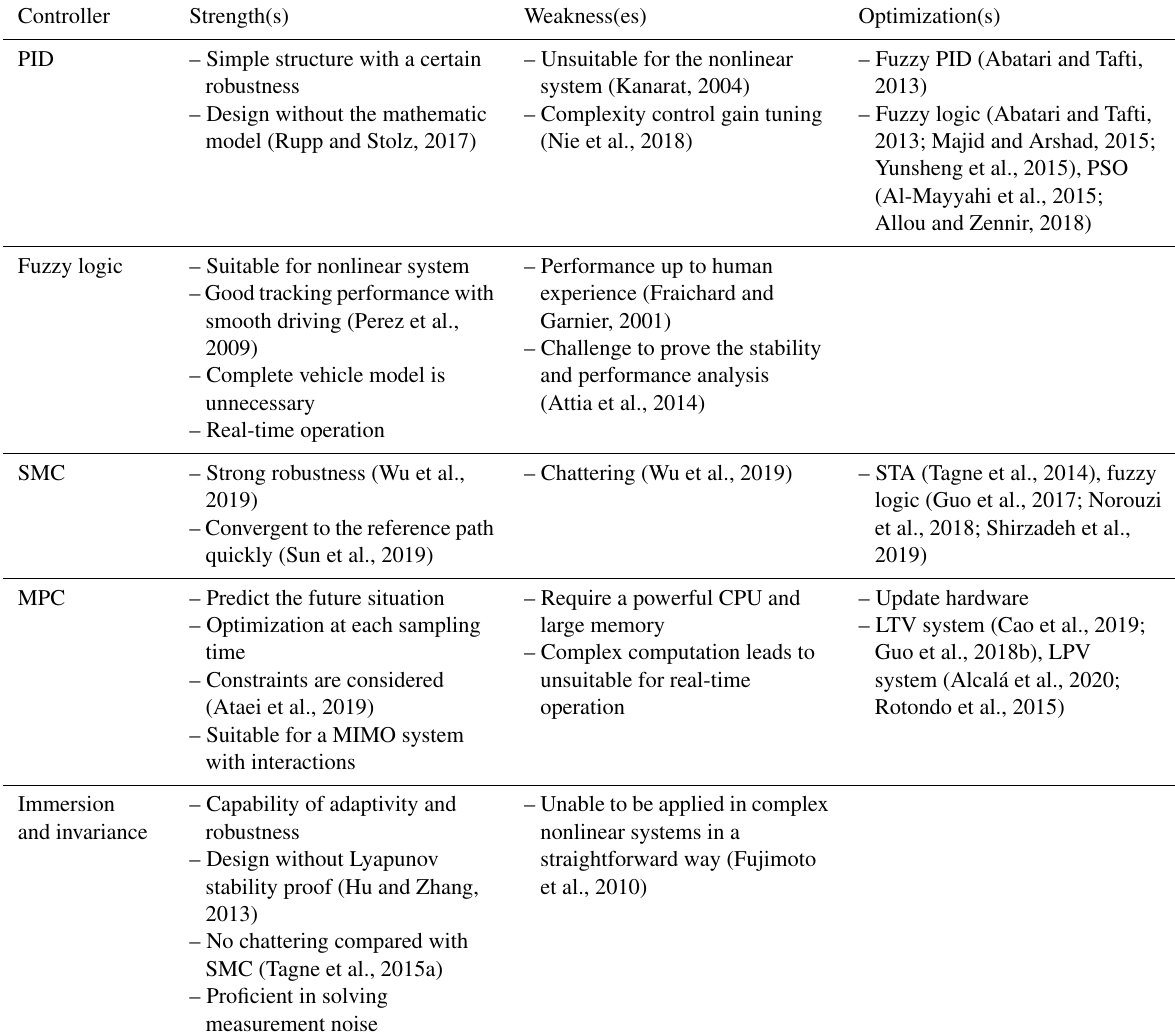
Table 1. Some weaknesses and strengths of each controller with some optimizations for moderating the weaknesses.